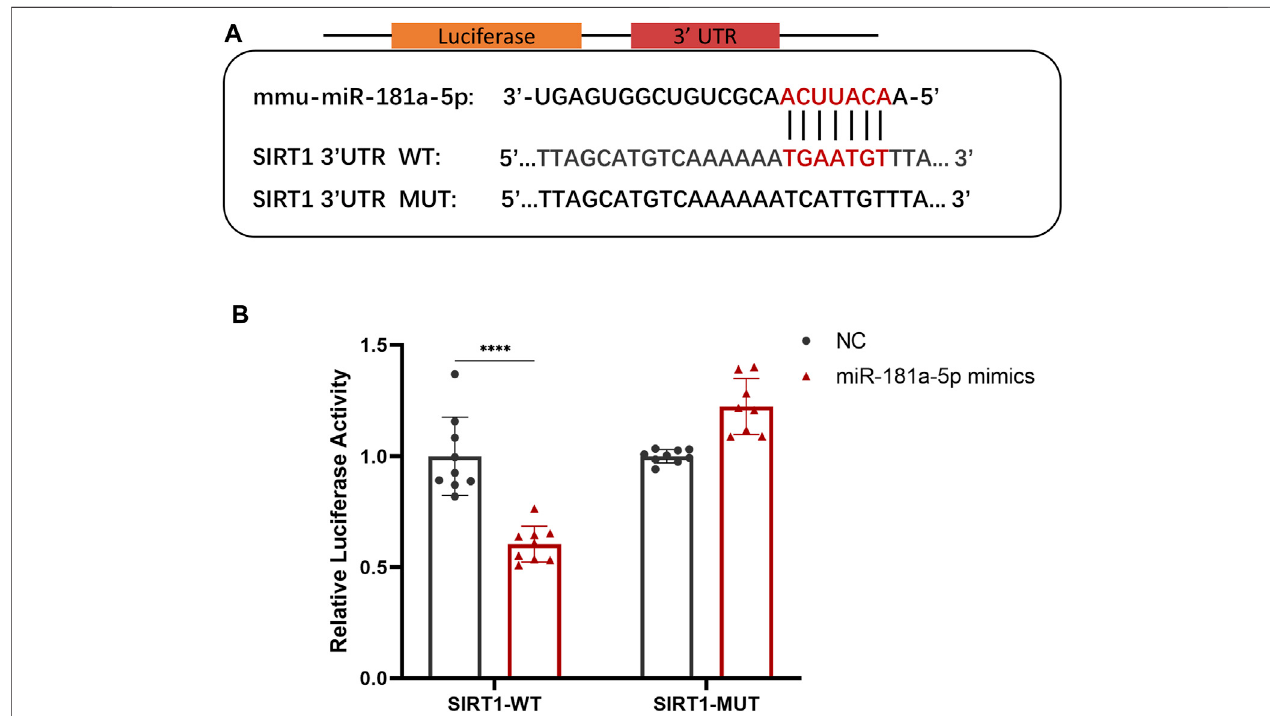
FIGURE3| MiR-181a-5pBinds Directlytothe3 ′ -UTRofSIRT1andInhibitsitsExpression. (A) SchematicrepresentationofmiR-181a-5pbindingsiteintheSIRT1 3 ′ UTR,whichwerepredictedbydatabase. (B) Relativeluciferaseactivitydetectedusingdual-luciferasereportergeneactivityassaysystem. n =9/group.Datapresented as Scatter dot plot with bar (mean ± SD). Statistical analysis was performed using two-way ANOVA with a Tukey ’ s multiple comparisons test. **** p < 0.0001.